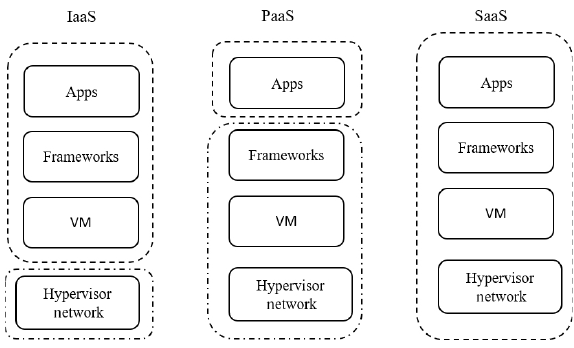
Fig. 3 Cloud computing services.